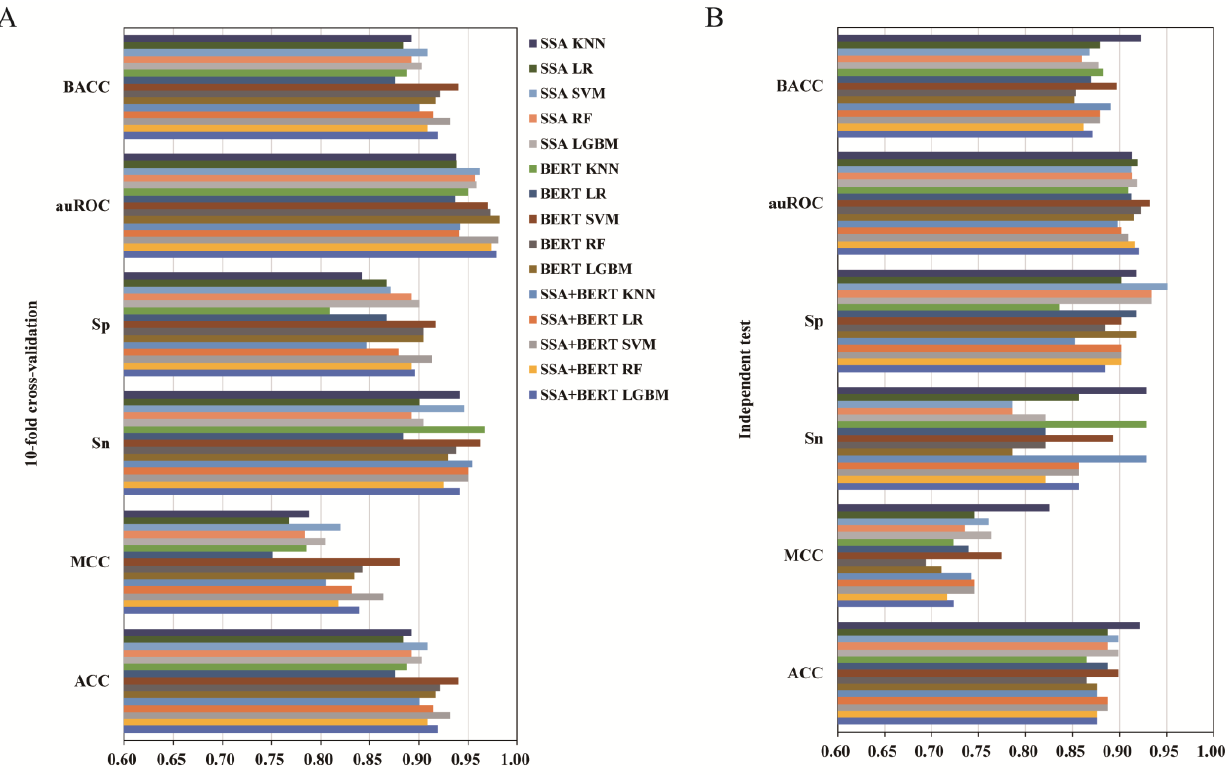
Figure 4. The performance metrics of individual and fusion features using selected features and